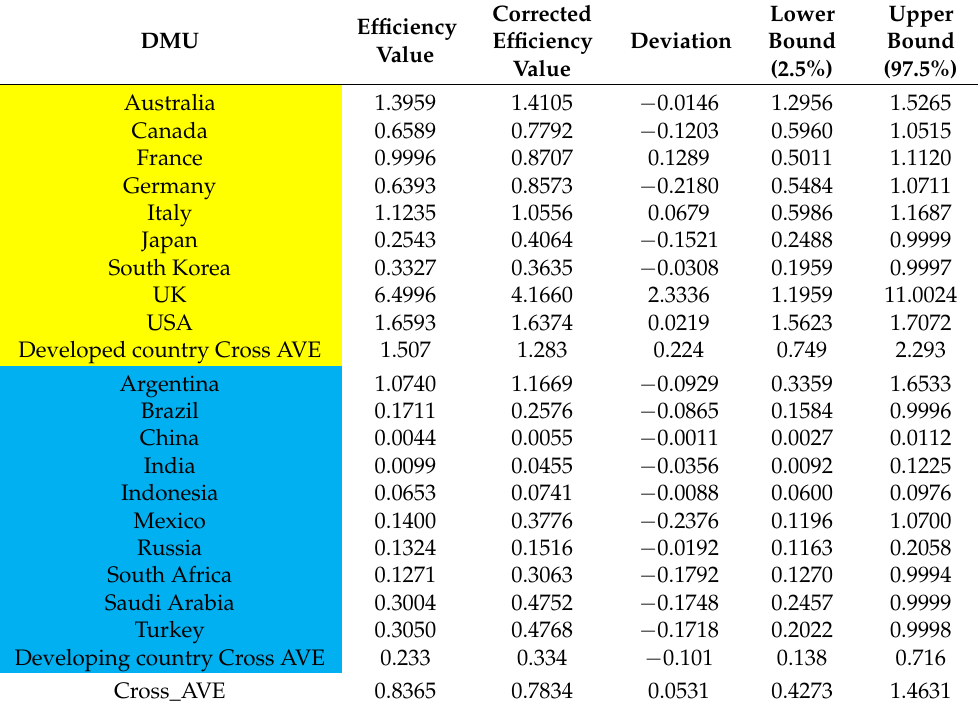
Table 3. Efficiency values and 95% confidence intervals for G20 economies.